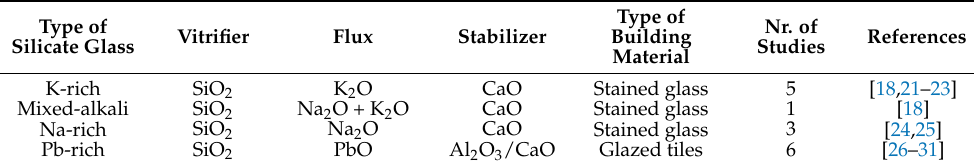
Table 1. Type of silicate glass used in the glass-based building materials described in the 21th century literature.